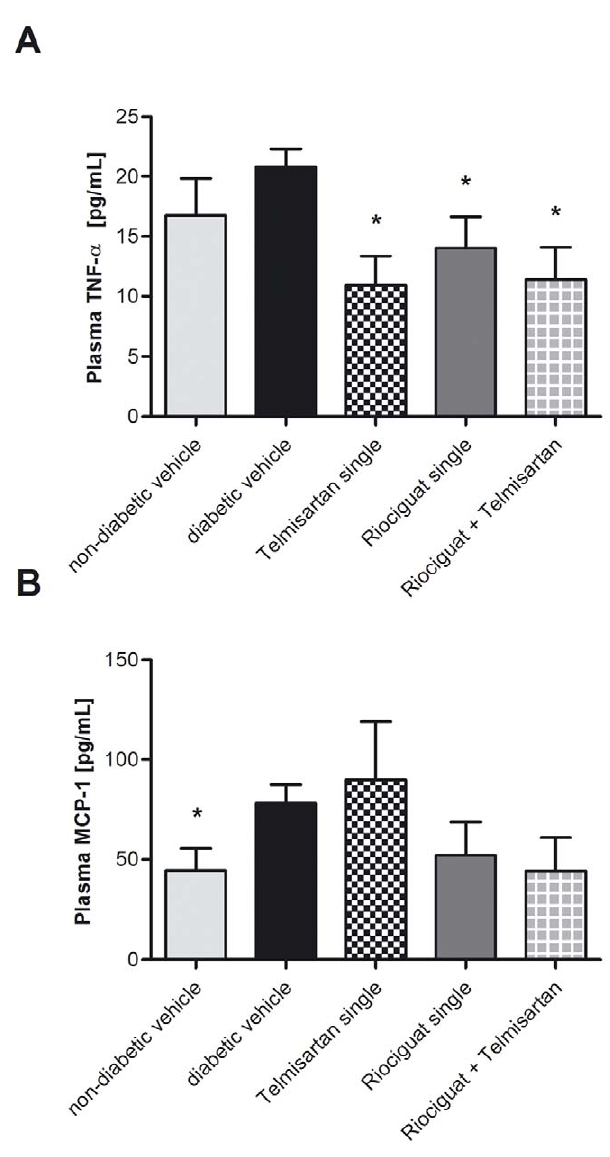
Figure 2. Final plasma parameters in treatment groups (riociguat, telmisartan, combination of both), diabetic and non-diabetic eNOS knockout mice. Values are given as means 6 SEM. For comparisons, student’s t test and Mann-Whitney u test, respectively, were used. * p , 0.05 vs. diabetic vehicle. Abbreviations used: MCP-1 , monocyte chemoattractant protein-1; TNF- a , tumor necrosis factor-alpha.